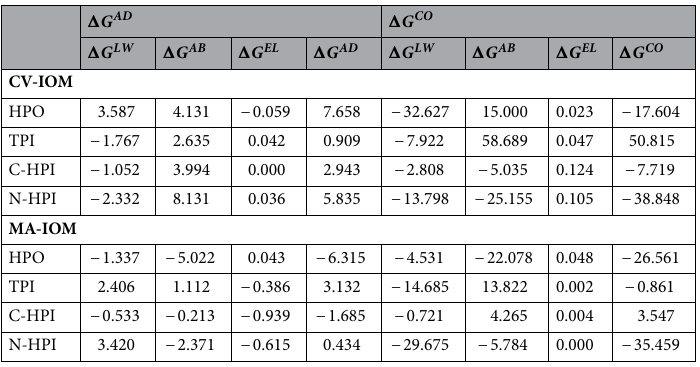
Table 5. Adhesion free energy between the membrane and foulants upon contact and cohesion free energy between membrane and